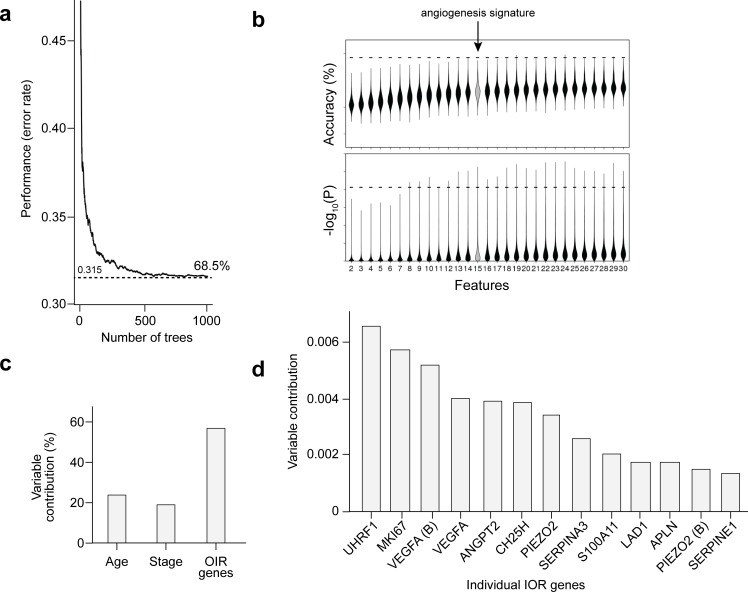
Machine learning performance and OIR gene contribution.(a) Performance (error rate) per number of tree generated by the random forest algorithm. (b) Resulting classifier was evaluated against a null distribution of classifiers. The y axis of top plot indicates the accuracy while the bottom plot highlights the -log10(P). Larger values indicate a lower P-value and hence a more statistically significant separation of patient groups in the validation dataset. Dashed lines indicate performance of chosen model; Gray object highlight the number of features used on the chosen model; the same strategy of stratifying samples on low, intermediate and high-risk group was applied and evaluated using the log-rank test. (c and d) Contribution of each feature (age, stage or IOR genes) for the prognostic power of the algorithm.